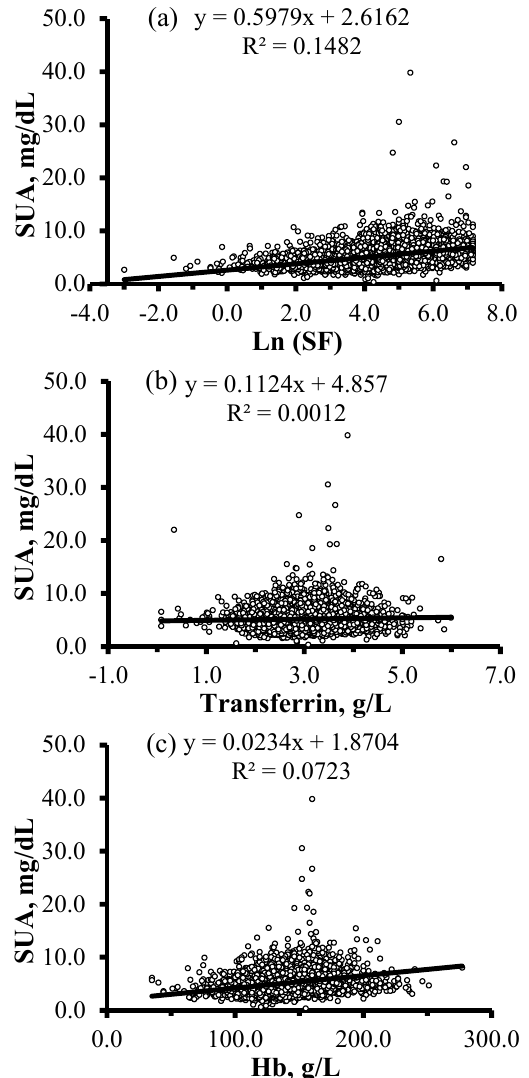
Figure 1. SUA concentrations ( a ) and crude prevalence of HU ( b ) for 7946 participants according to their age and gender. Data of SUA concentrations were expressed as means ± standard error (SE). SUA, serum uric acid; HU, hyperuricemia.